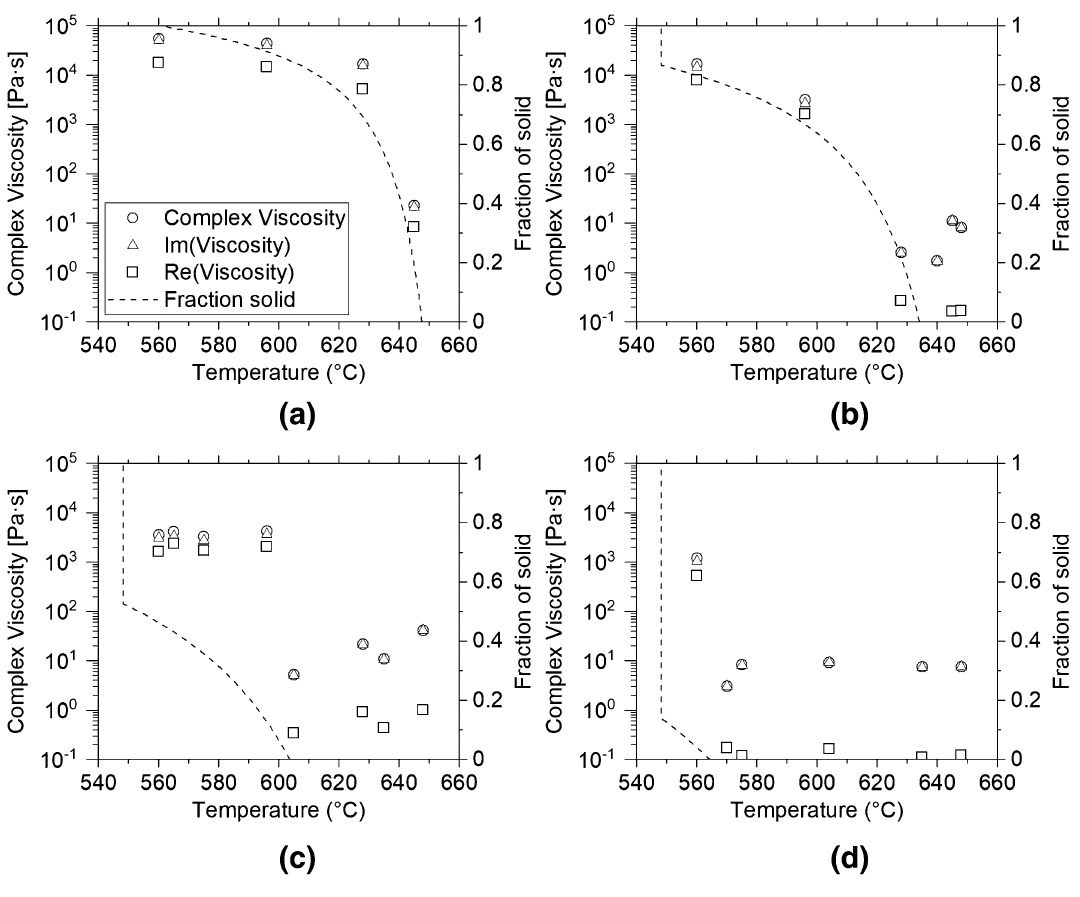
Fig. 7 Oscillatory measurements at an amplitude of 1 mrad and a frequency of 1 Hz- a 5%, b 10%, c 20% and d 30% (by weight)